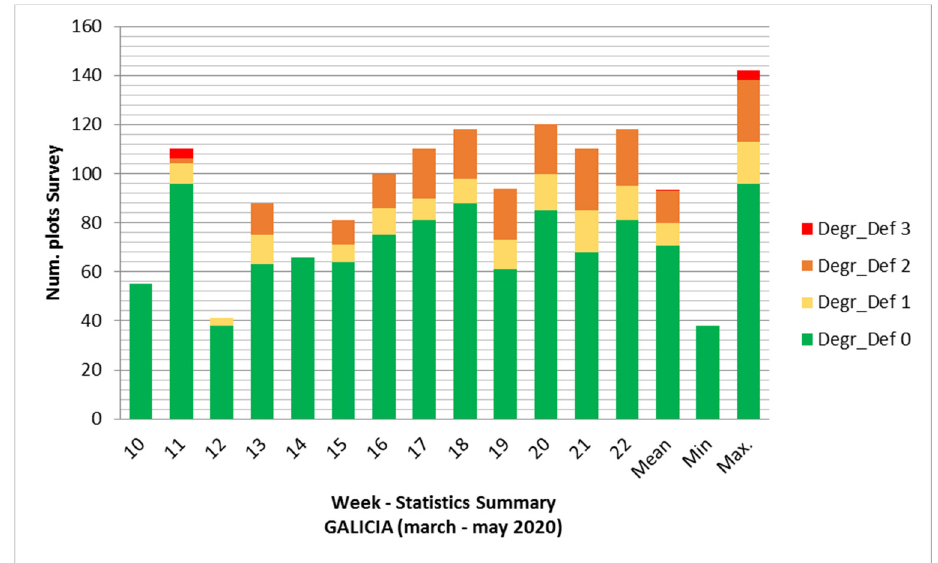
Figure 6. Number of plots sampled in Galicia in 2020 by week and degree of defoliation.